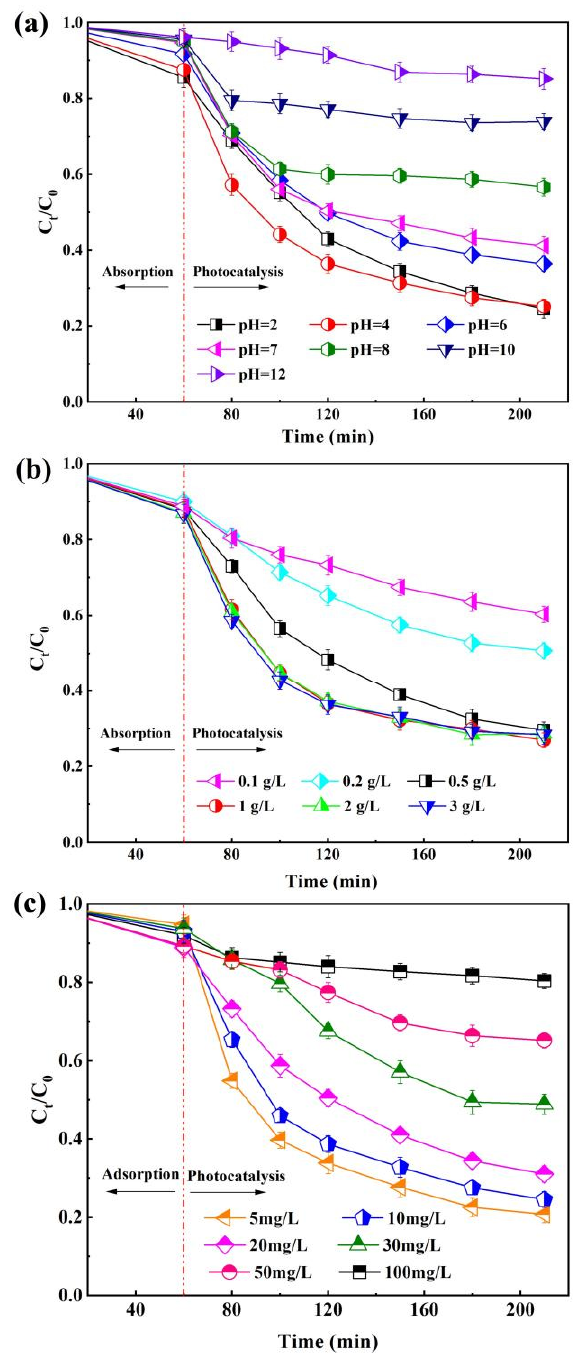
Figure 7. Degradation efficiency of TC versus time with ( a ) different initial pH values, ( b ) doses of CDBPC composite, and ( c ) initial TC concentrations.